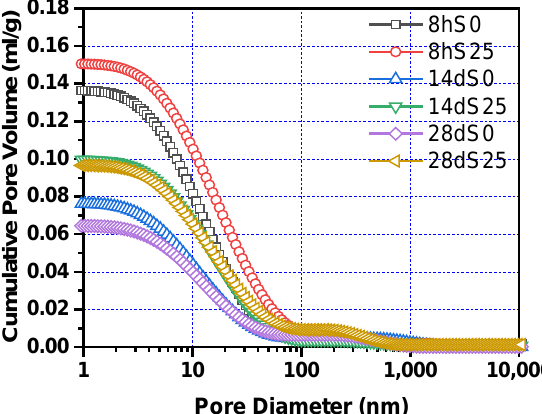
Figure 10. Cumulative pore volume of S0 and S25 at different times.